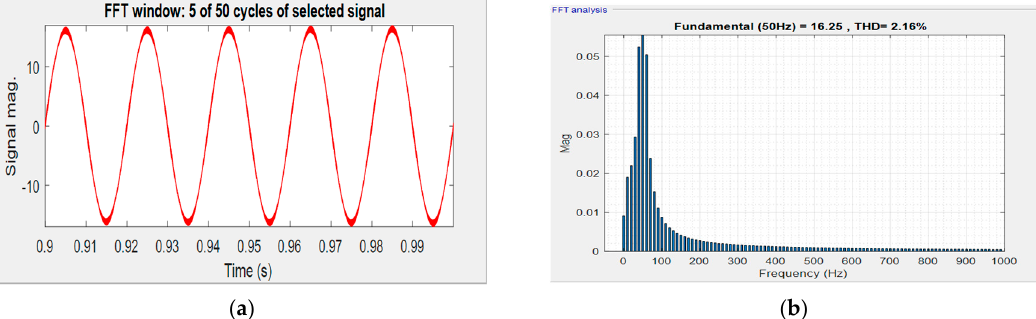
Figure 10. ( a ) Phase A current drawn from utility. ( b ) Total harmonic distortion (THD) analysis of phase A current.